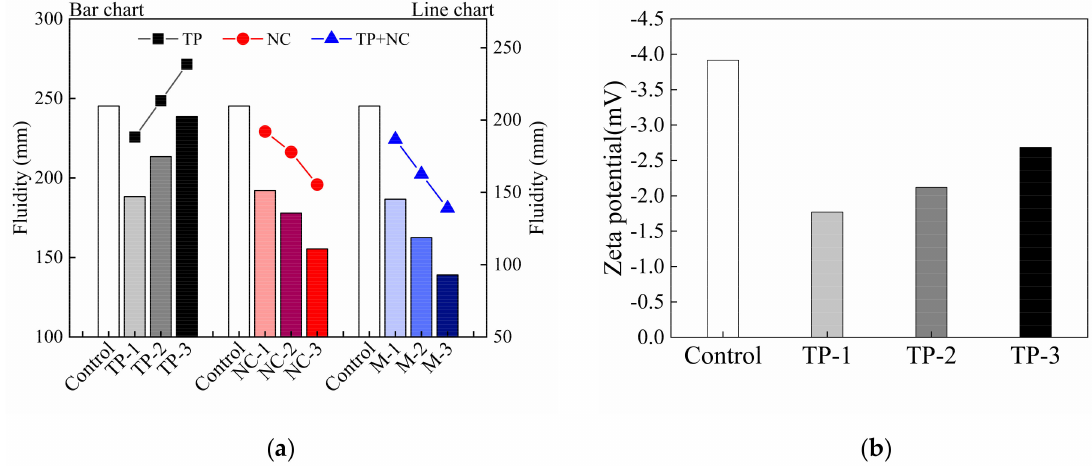
Figure 11. ( a ) The fluidity of mixtures and ( b ) zeta potential of cement particles with TP and PCE